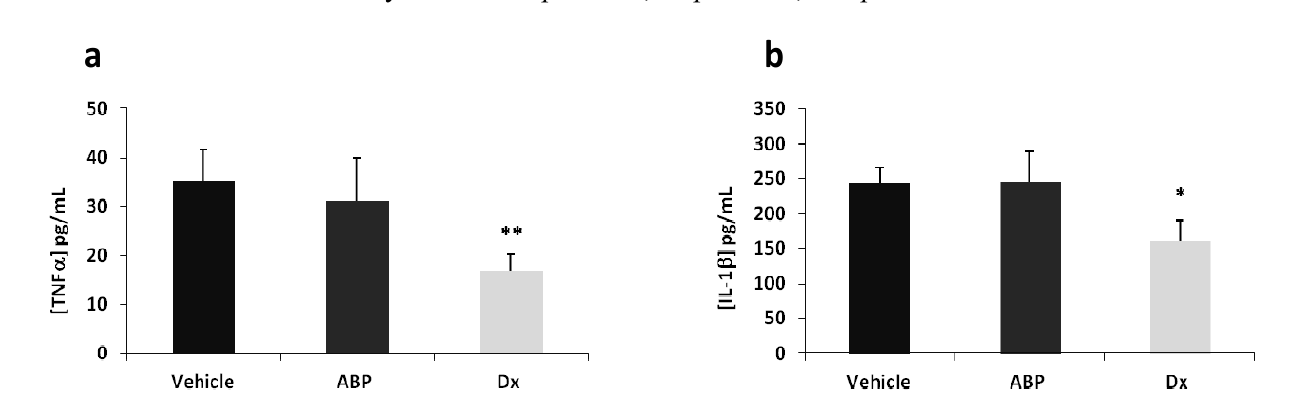
Figure 3. Cytokine concentrations (pg/mL) in aqueous humor and vitreous. Multiplex analysis was achieved 24 h after EIU induction. Dendrimer ABP was administered at 2 µg/eye. Dx is for dexamethasone at 20 µg/eye. ( a ) TNF α , ( b ) IL-1 β , ( c ) IL-2, ( d ) IL-10, ( e ) IL-6, ( f ) IL-17, ( g ) IL-4 and ( h ) IFN γ . Histograms represent the mean of concentration measurements in each eye + SEM. * p < 0.05, ** p < 0.01, *** p < 0.001 vs. saline